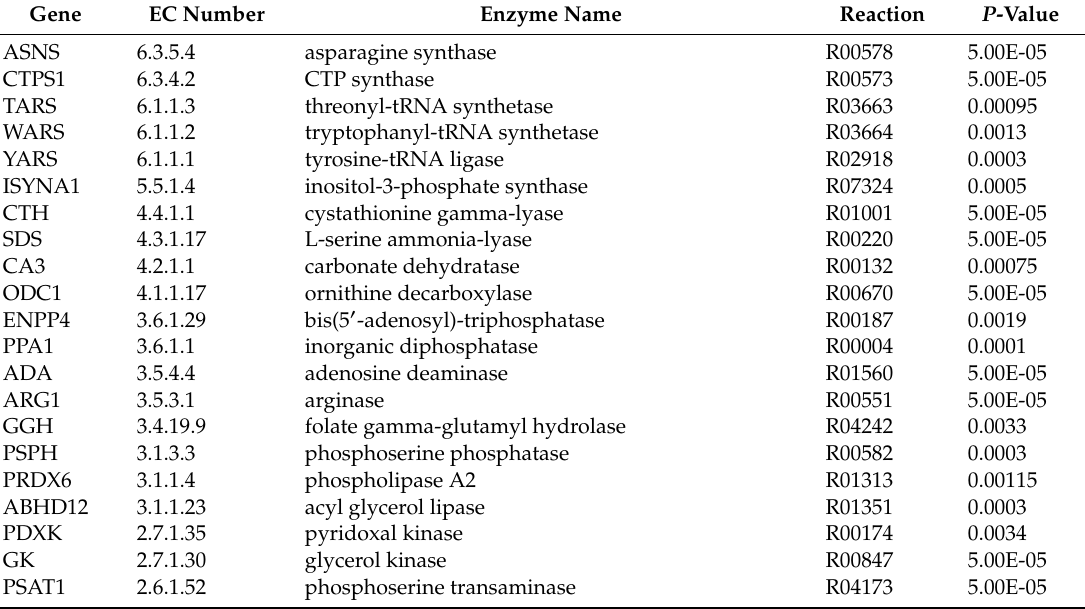
Table 5. The top down-regulated enzyme in the bovine rumen tissue under acidosis